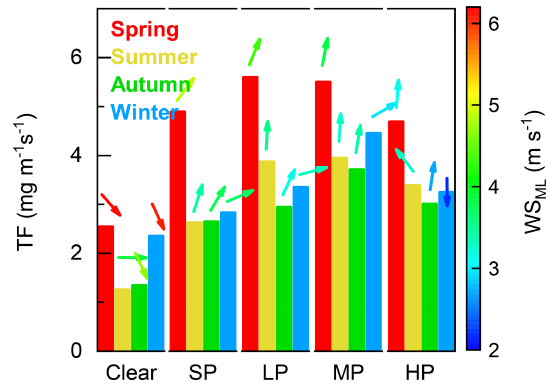
Figure 8. The mixing layer TF of the PM 2 . 5 levels and transport directions under different degrees of pollution in different seasons in Beijing. (SP denotes slight pollution, LP denotes light pollution, MP denotes medium pollution and HP denotes heavy